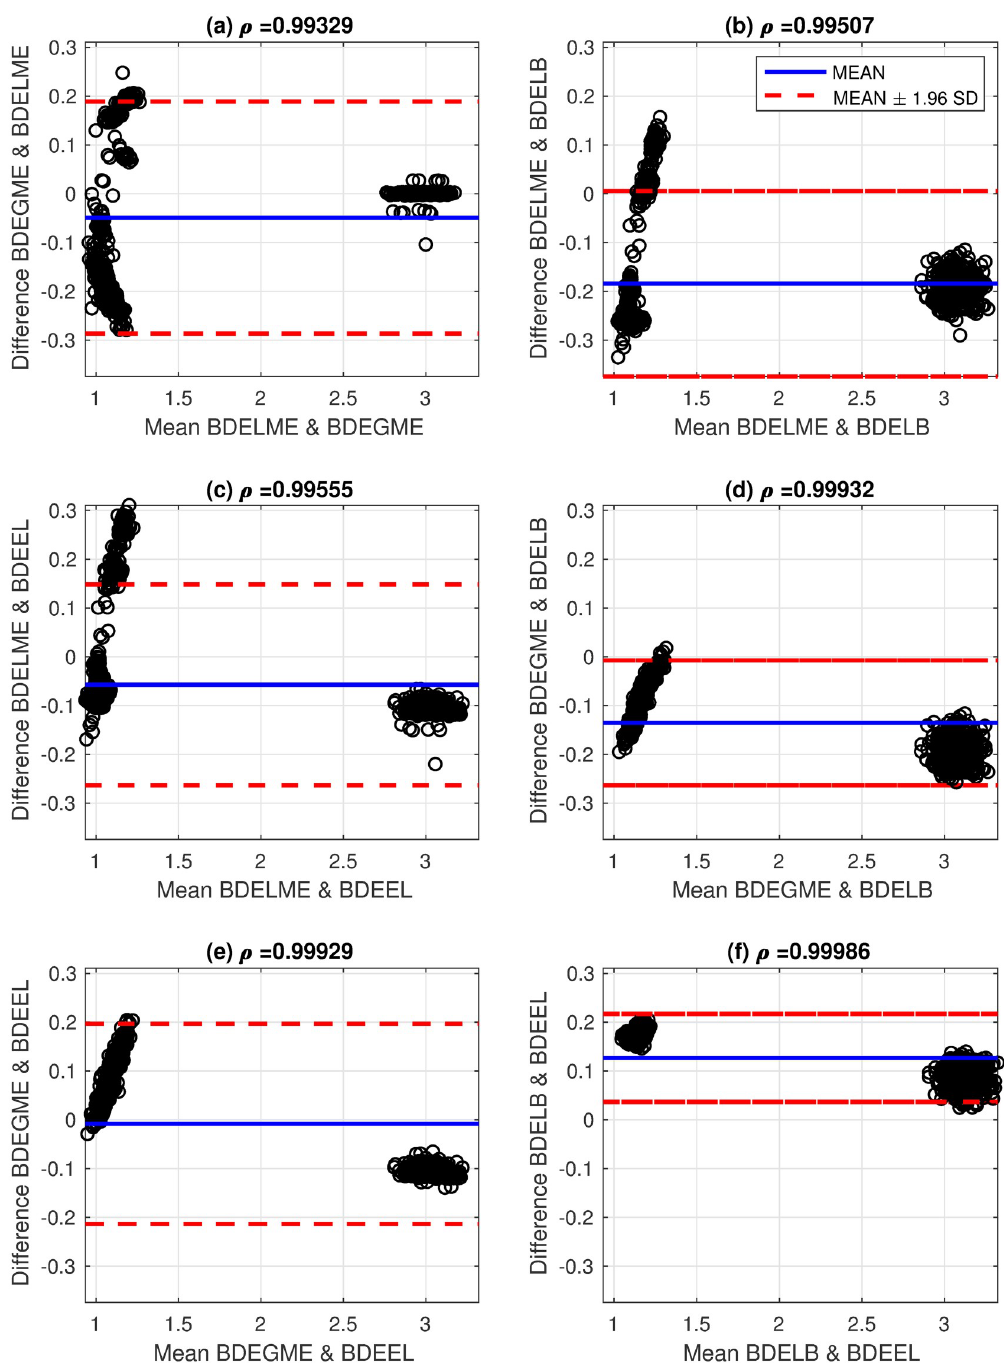
Fig 10. Bland-Altman plots for estimated average lifetimes with fluorescence dyes in channel 2 (494 ± 41 nm) and correlation coefficients: (a) BDELME vs BDEGME, (b) BDELME vs BDELB, (c) BDELME vs BDEEL, (d) BDEGME vs BDELB, (e) BDEGME vs BDEEL, and (f) BDELB vs BDEEL.